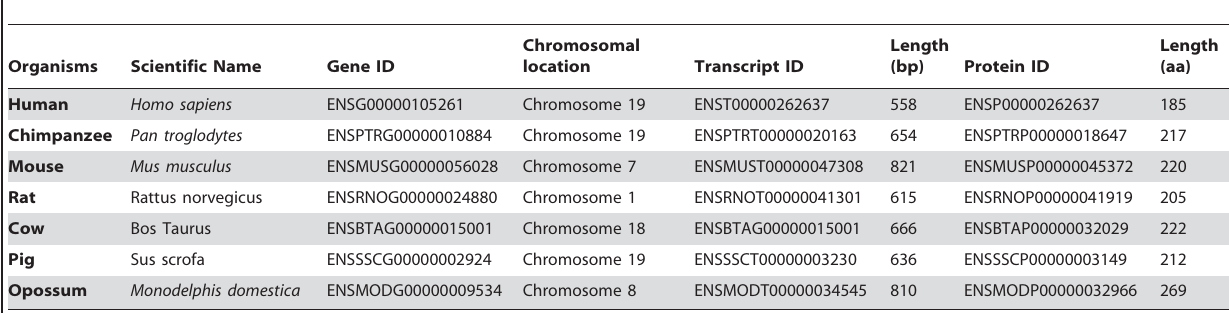
Table 3. List of OVOL3 genes from selected mammalian genomes, identified from Ensembl database release 58 (May 2010).